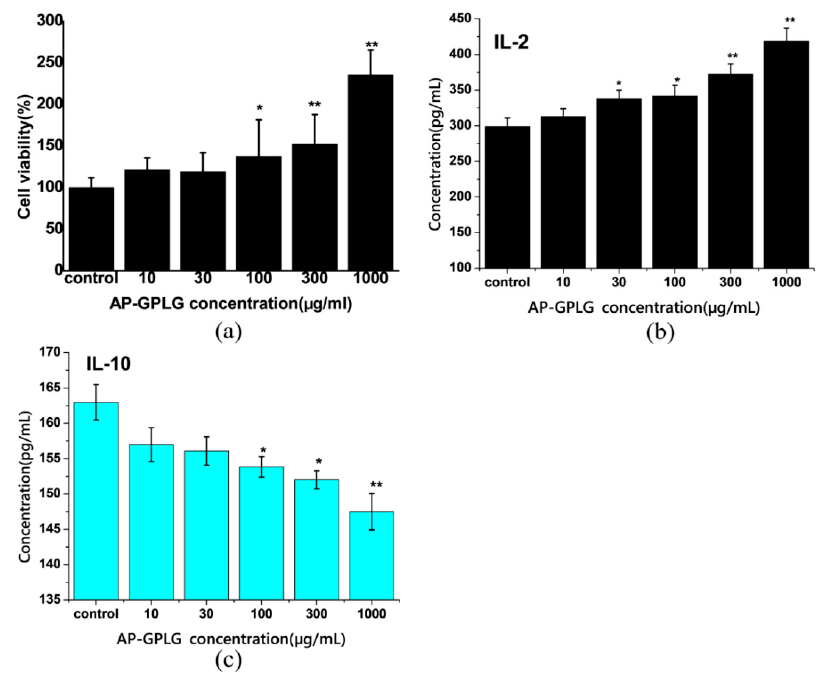
Figure 8. Effect of AP moiety (AP-GPLG) on proliferation of mouse spleen cells ( a ), IL-2 secretion ( b ), and IL-10 secretion ( c ). Data were expressed as the mean ± SD. ( n = 6 in A, n = 3 in B and C, * p <0.05, ** p < 0.01 vs.